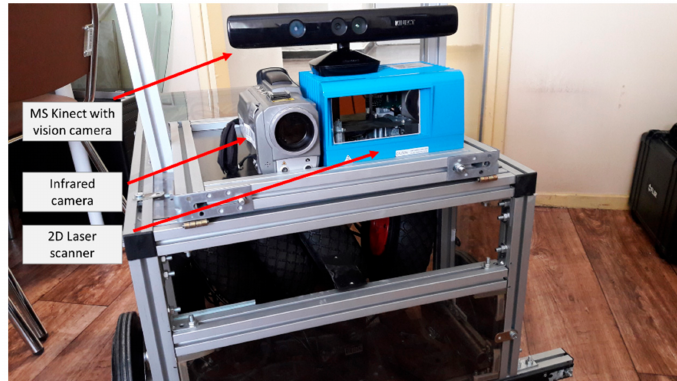
Figure 3. Test platform equipped with vision camera, infrared camera, and laser scanner.